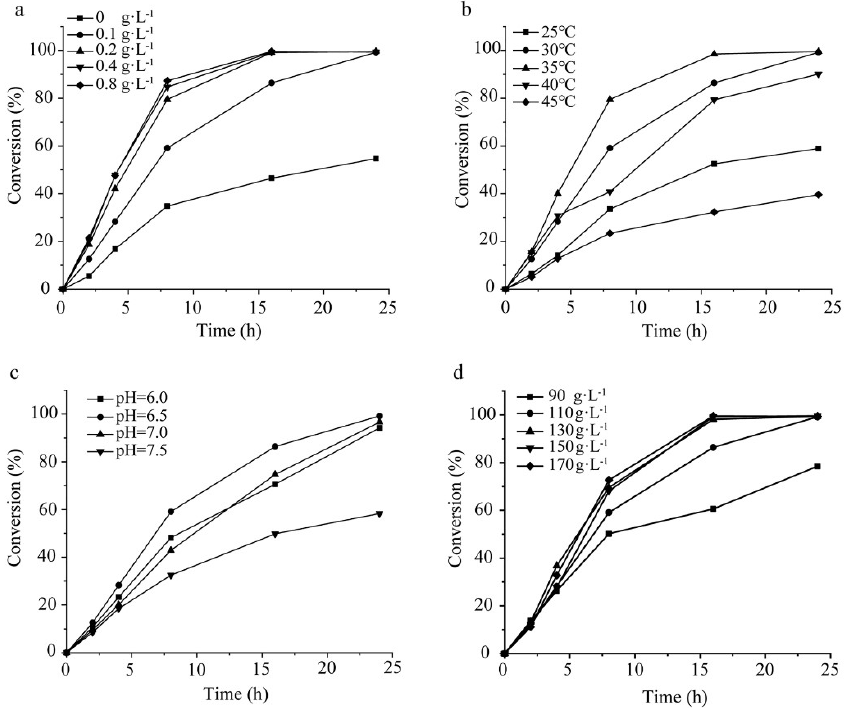
Figure 4. Optimization of the catalytic conditions of E. coli /pET28 − K − rbs − G. ( a ) NADP + concentra- tion. ( b ) Temperature. ( c ) pH. ( d ) Glucose concentration. All values are means from three individual measurements and standard errors of mean did not exceed 5%.